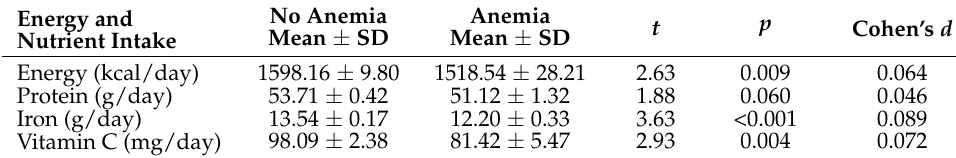
Table 3. Energy and nutrient intake amount by anemic status.